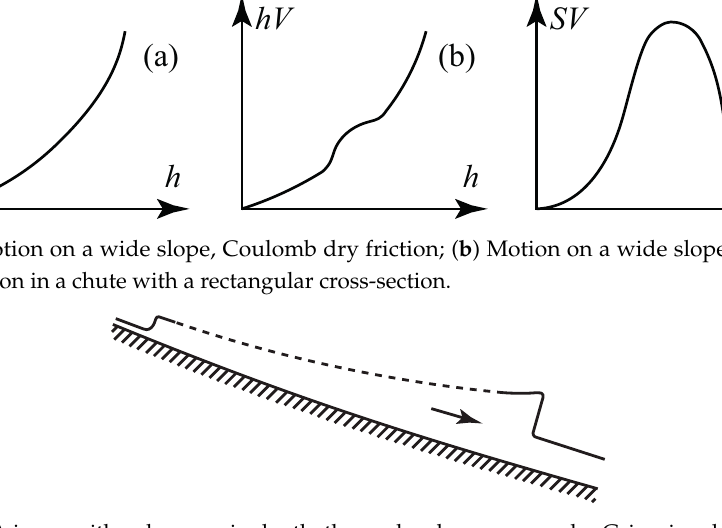
Figure 7. A jump with a decrease in depth; the avalanche moves under Grigorian dry friction.